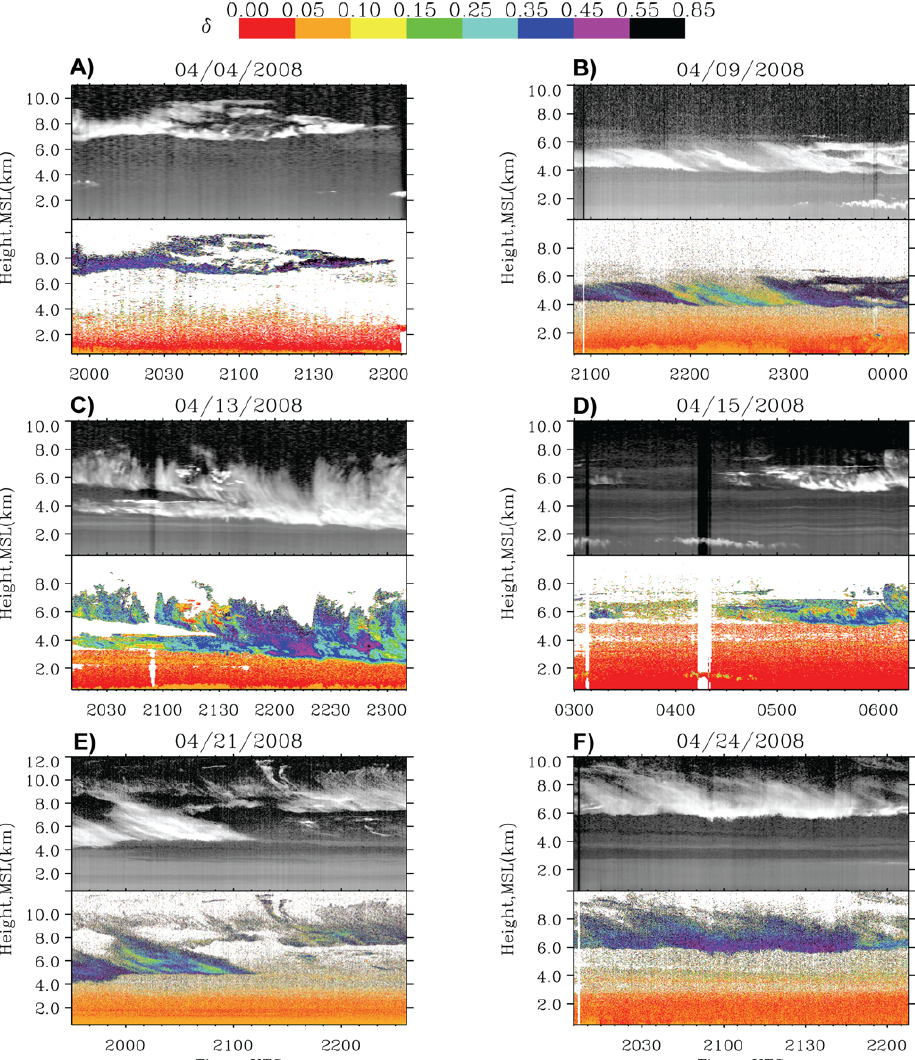
Fig. 2. AFARS lidar height-time display plots of the evolution of troposphere cloud and aerosol conditions during the ARCTAS campaign; the best six plots were selected to be spaced relatively evenly throughout the month of April. Each plot contains two images: the upper image shows relative returned (attenuated) lidar backscatter power in terms of a logarithmic gray scale (where white is the strongest range- normalized signal); the lower image shows lidar linear depolarization ratio ( δ) (note color scale at top of figure). All displays start at an altitude of 0.5kma.m.s.l. because signals are unreliable in the first 200m or so due to incomplete laser/receiver overlap. White areas in the depolarization displays have insufficient signals to calculate delta. Time values are in UTC, and the date of lidar data collection period is at the top of each image; in the text they are referred to as: (A) 4 April; (B) 9 April; (C) 13 April; (D) 15 April; (E) 21 April; (F) 24 April. An additional set of lidar data are available for 19 April, which and are presented in Fig.